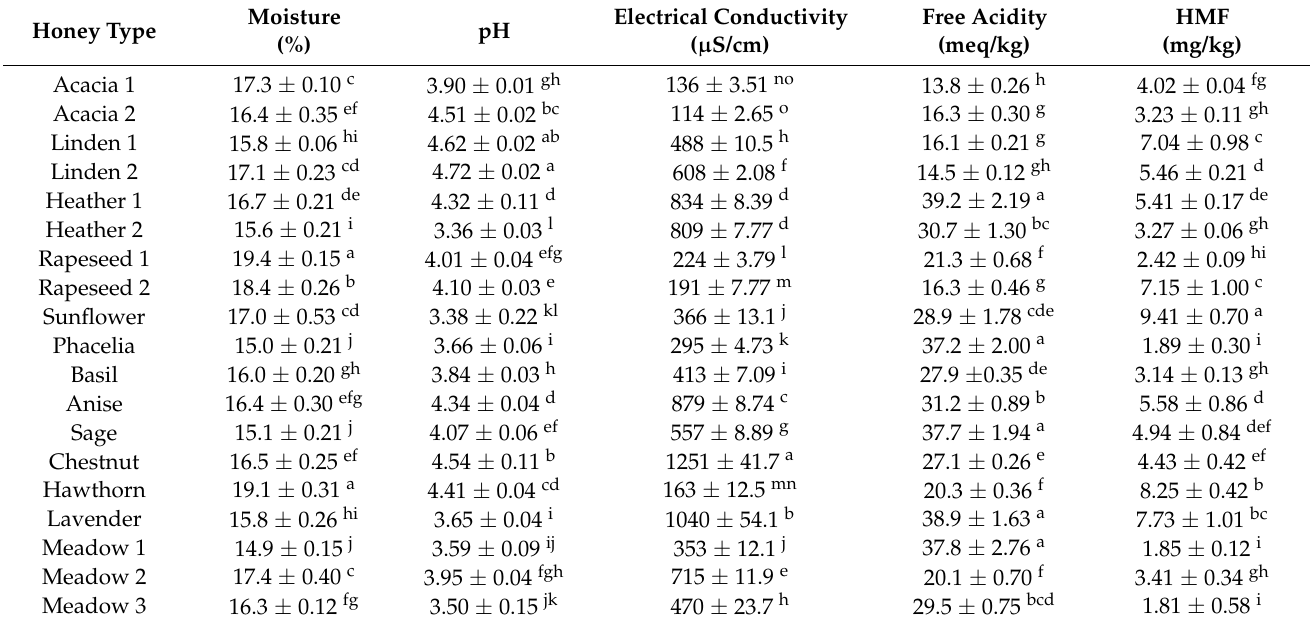
Table 2. Physicochemical parameters of different types of